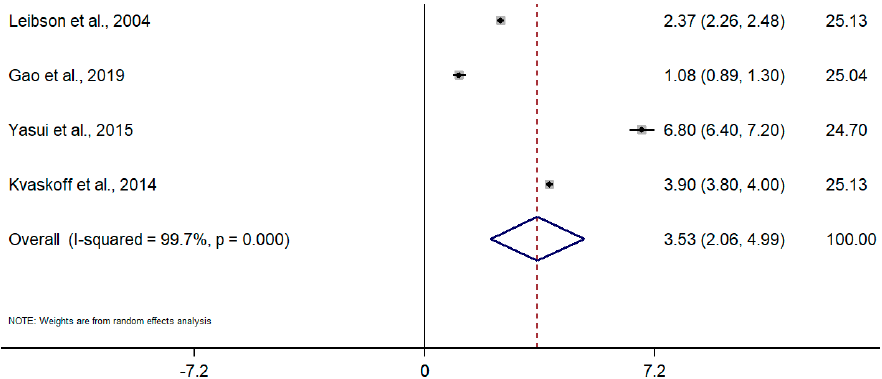
Figure 5. Meta-analysis of the incidence of endometriosis per 1000 person-years based on hospital discharge databases. Note: black lines with squared dots—the prevalence with confidence intervals for each individual study; rhombus—pooled prevalence with confidence interval; red dotted line— line of no effect (studies crossing the line are not statistically different).